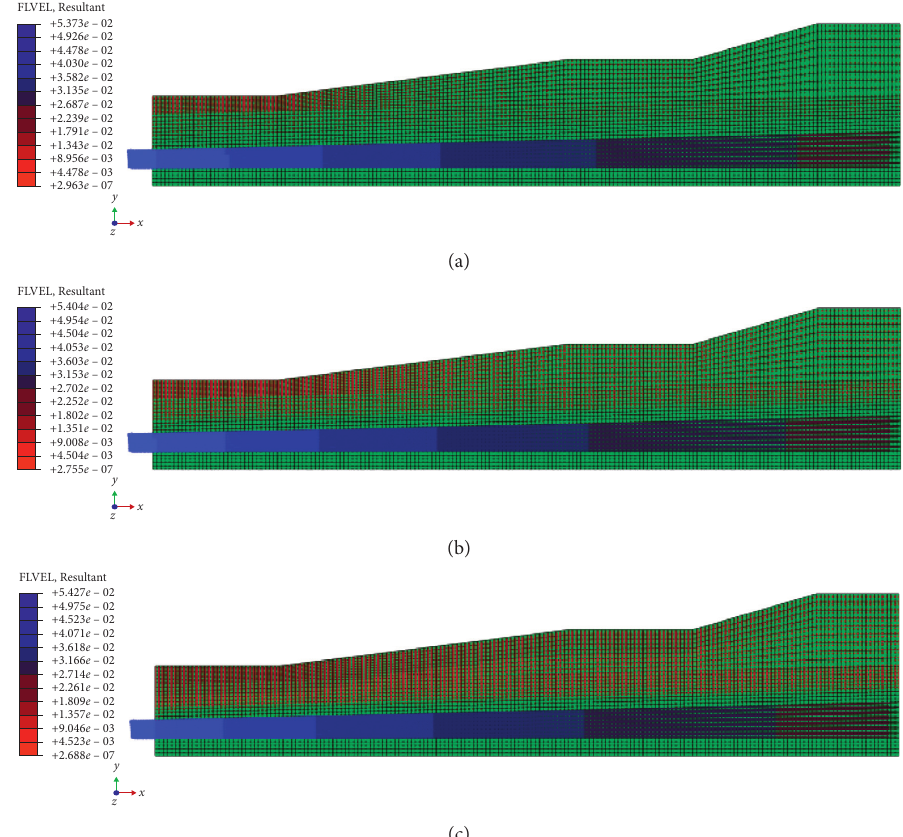
Figure 6: Distributions of fluid velocity under different rainfall intensities. (a) Rainfall intensity is 40mm/d. (b) Rainfall intensity is 80mm/d. (c) Rainfall intensity is 160mm/d.